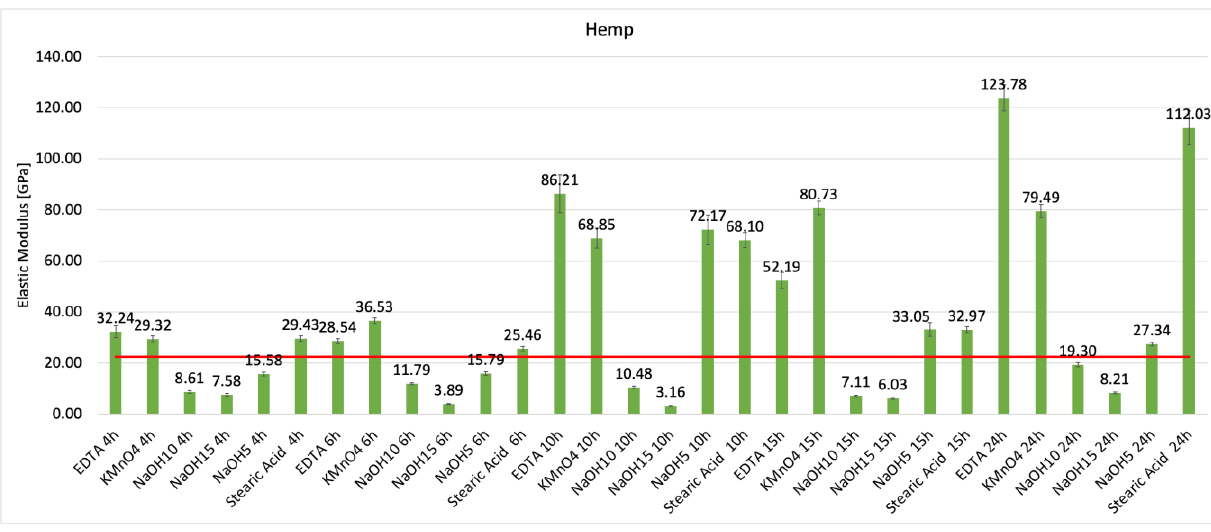
Figure 11. Elastic modulus obtained for each treatment on hemp fibres. Analysing the effects of the two selected treatments (stearic acid 4 h for flax and